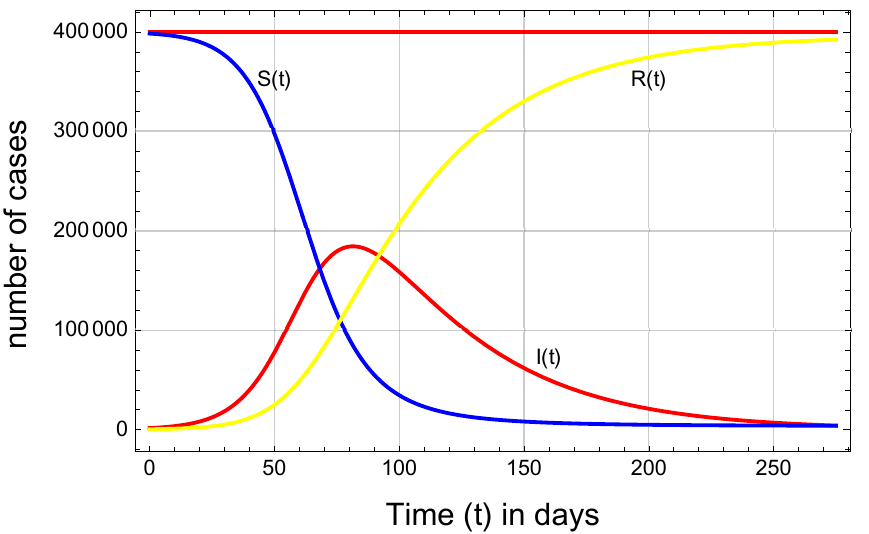
Figure 3. The behavior of the components of the SIR model due to parameters calculated from April to the end of